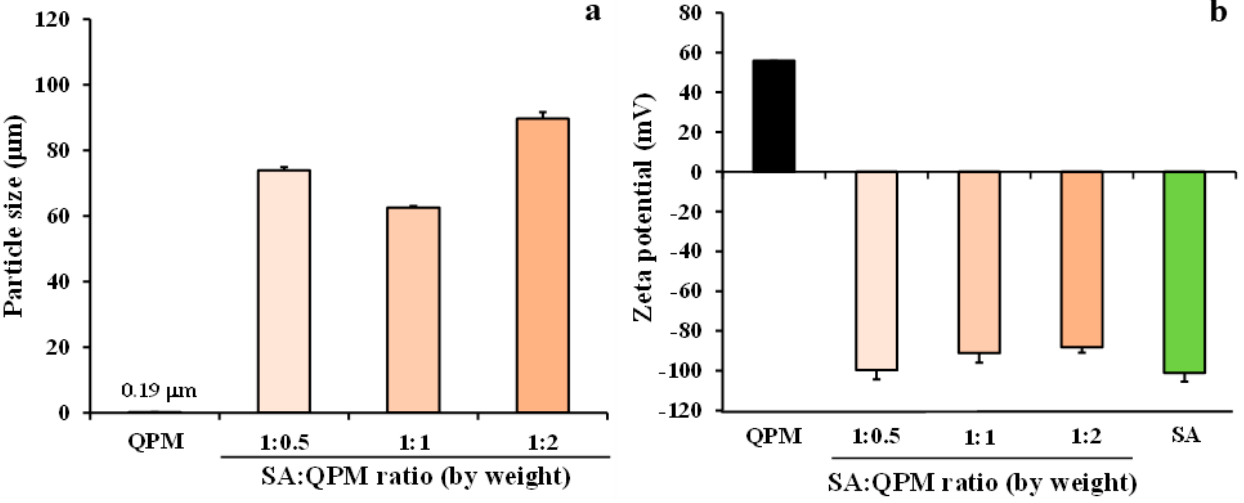
Figure 3. Particle size ( a ) and zeta potential ( b ) of dispersed phase in QPM, SA, and SA-QPM dispersions. Each value is the mean ± S.D., n = 3.